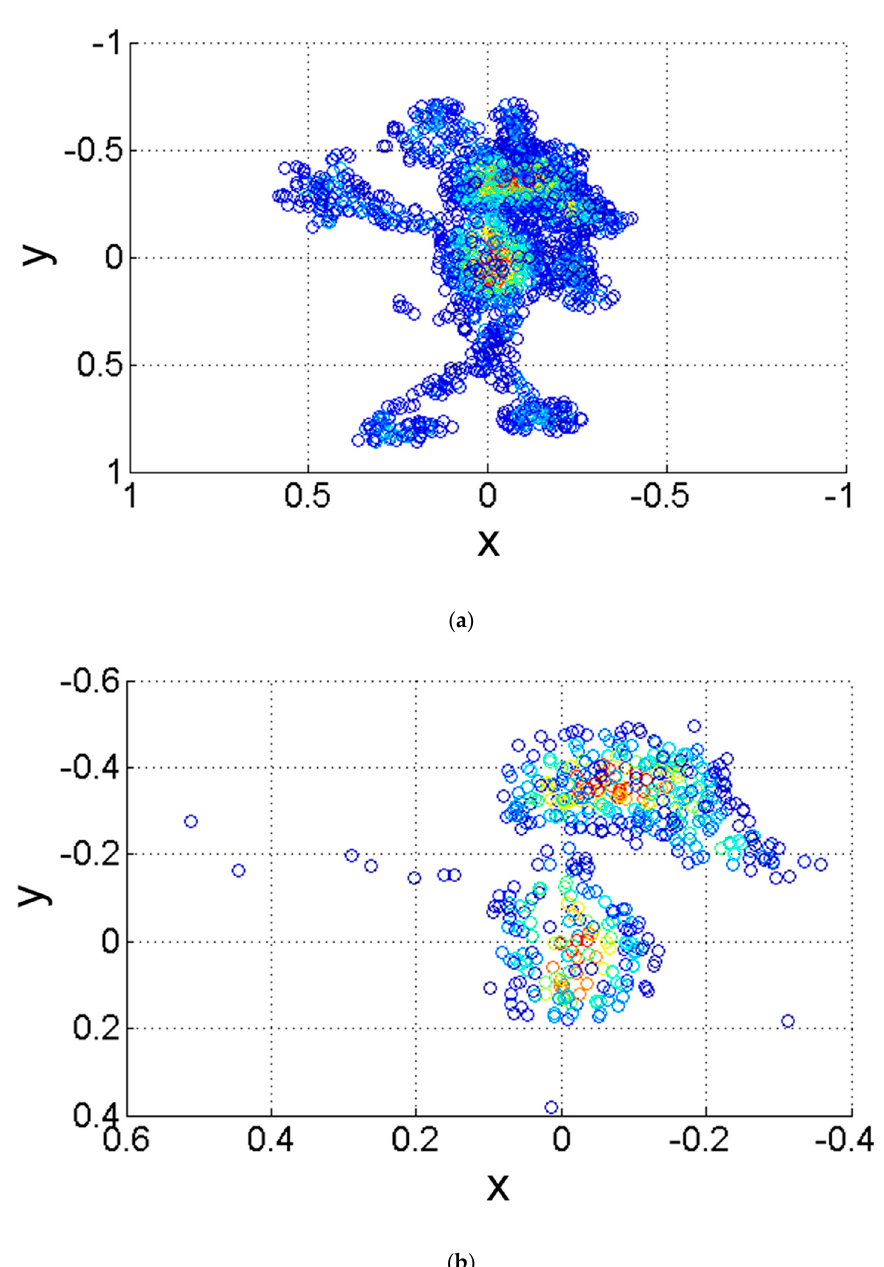
Figure 1. ISR (implicit shape representation) and WISR (weighted implicit shape representation) of mouse model; ( a ) ISR; ( b ) WISR. mouse model; ( a ) ISR; ( b )